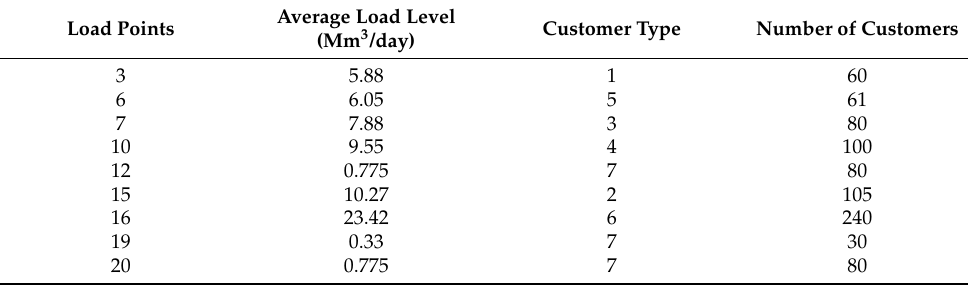
Table A3. A 20-node Belgian natural gas system load and customer data